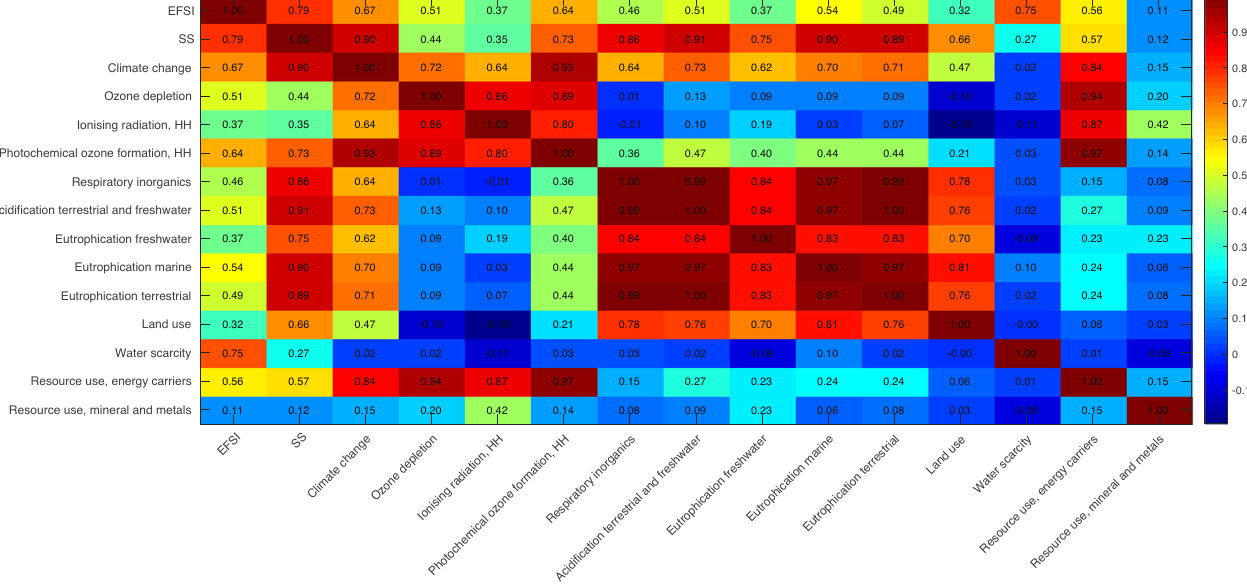
Fig. 3 Heatmap representing the correlations between the 13 environmental impacts and the two single indexes, EFSI and EC single Score. The heatmap shows which impacts have higher correlation with each other and with each